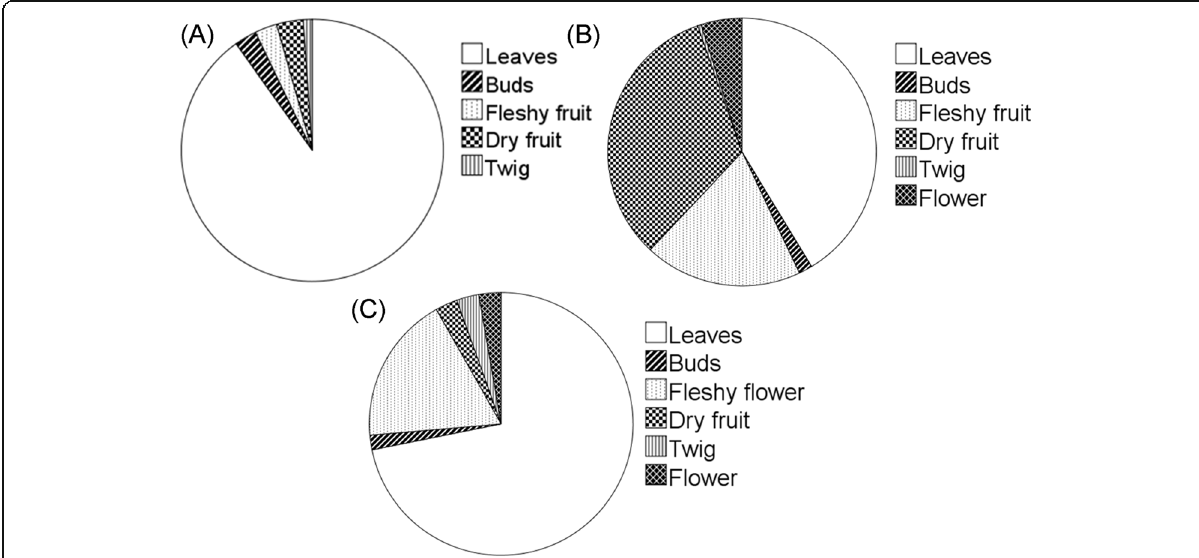
Fig. 2 Seasonal composition (%) of different plant parts in the four-horned antelope ( T. quadricornis ) diet in the tropical deciduous forests of southern Rajasthan, India ( a , winter; b , summer; c , monsoon)